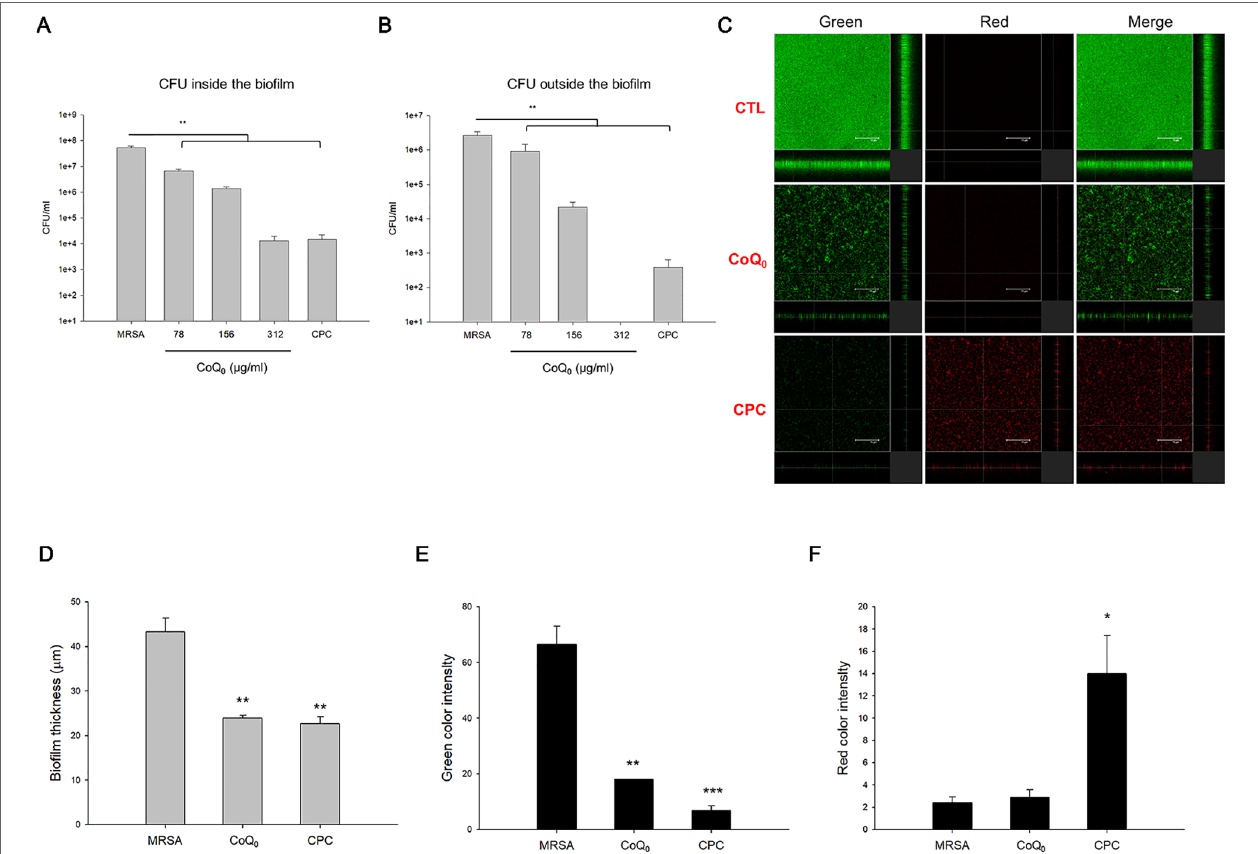
FIgURE 2 | Determination of the biofilm MRSA inhibition by CoQ 0 . (A) MRSA CFU inside the biofilm. (B) MRSA CFU outside the biofilm. (C) The three-dimensional images of biofilm analyzed by ClsM . (D) The corresponding biofilm thickness analyzed by ClsM . (E) Quantification of green fluorescence intensity (live bacteria) of